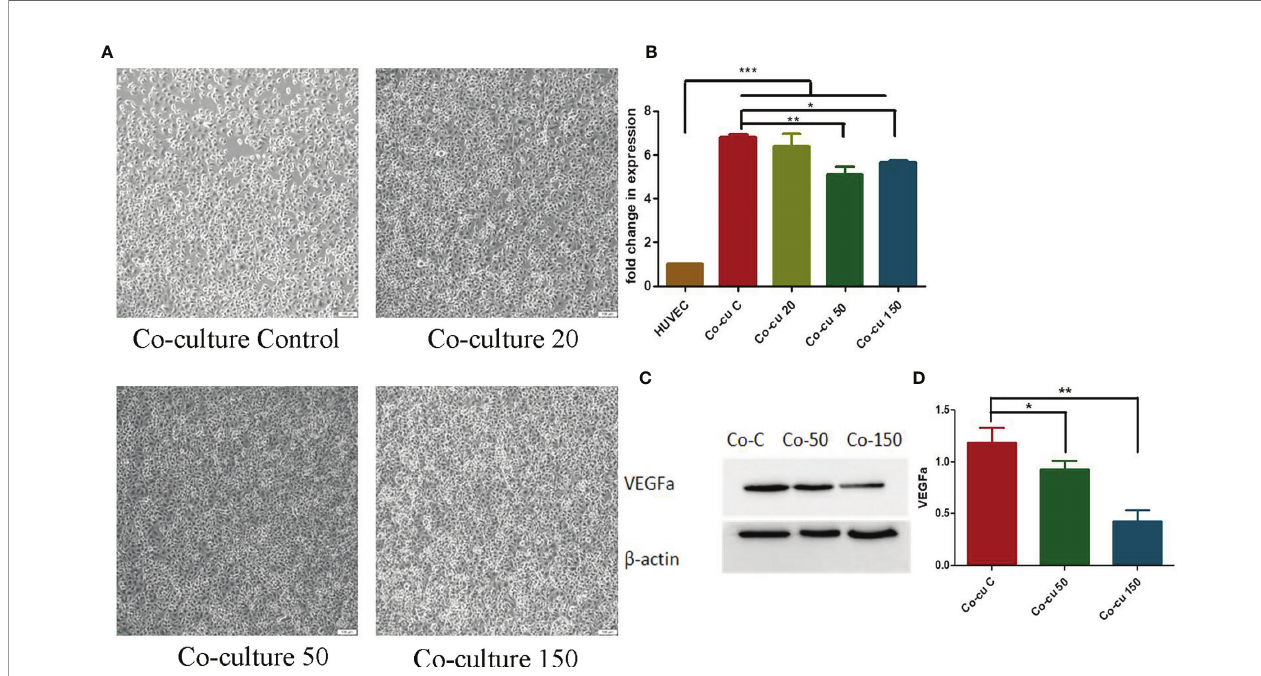
FIGURE 4 | The effects of essential oil from Curcumae rhizoma (CR) (OCR) on HUVECs co-cultured with HCT116 cells. (A) Changes in HUVEC morphology in the co-culture system at different OCR concentrations. (B) The effects of OCR on VEGFa mRNA expression in HUVECs. (C, D) The effects of OCR on VEGFa protein expression in HUVECs. (n = 3, mean ± standard deviation (SD), ***P < 0.001, **P < 0.01, *P < 0.05 compared with the control